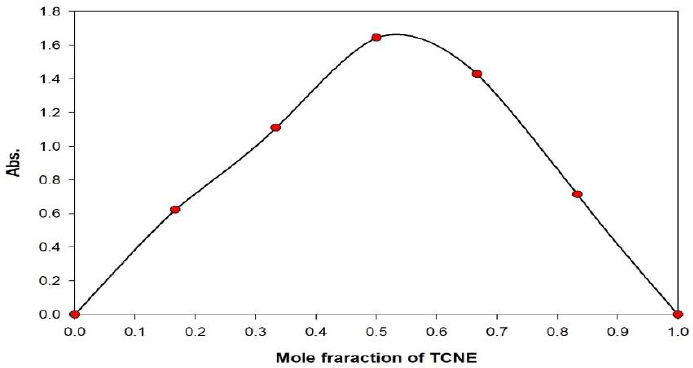
Figure 6. Job ’ s plot of AMFP – TCNE CT complex in DCE. Figure 6. Job’s plot of AMFP–TCNE CT complex in